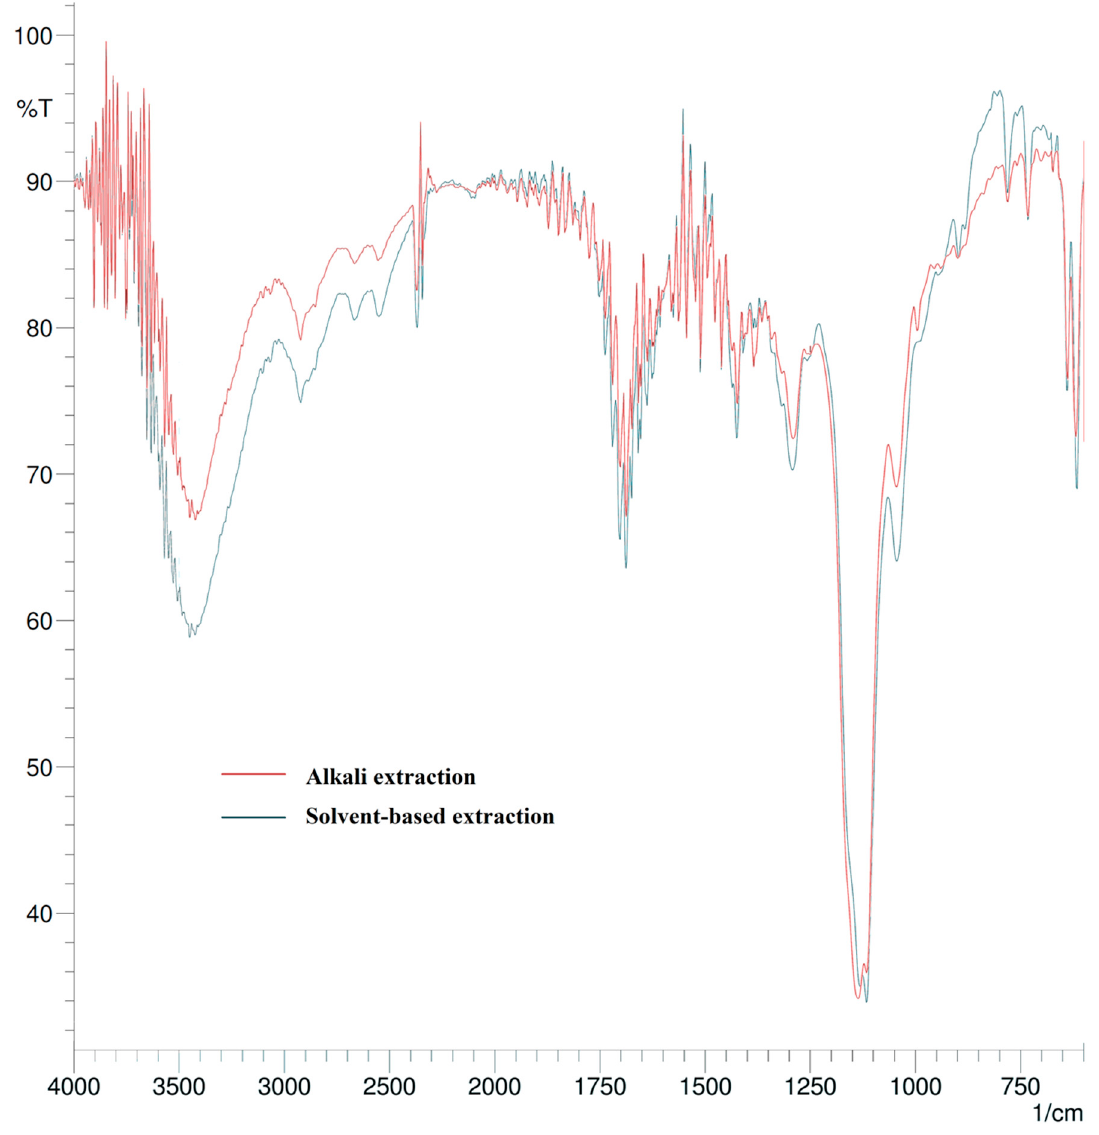
Figure 1. FT-IR spectra of lignin extractions in the wavenumber zone of 4000 − 600 cm − 1 . FT-IR spectra of the lignin extract by alkaline treatment (red) and by organic solvent treatment (blue).